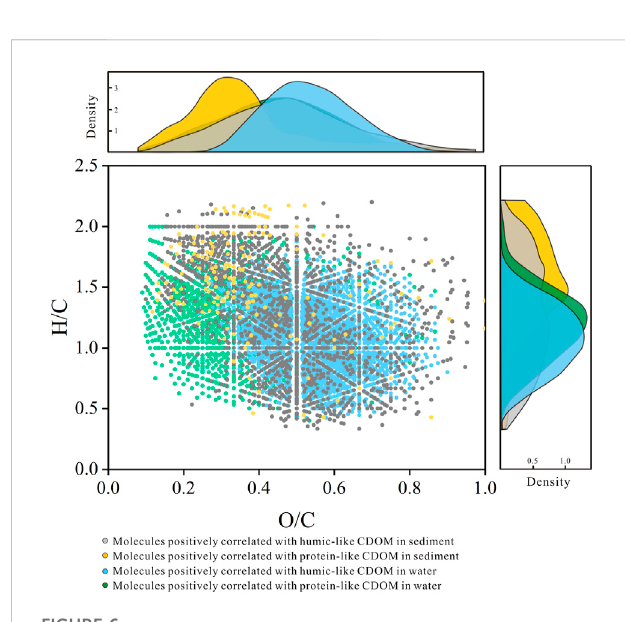
FIGURE 6 Van Krevelen diagram with marginal density plots of molecules of WEOM in sediment and DOM in water that correlated with chromophoric dissolved organic matter (CDOM)